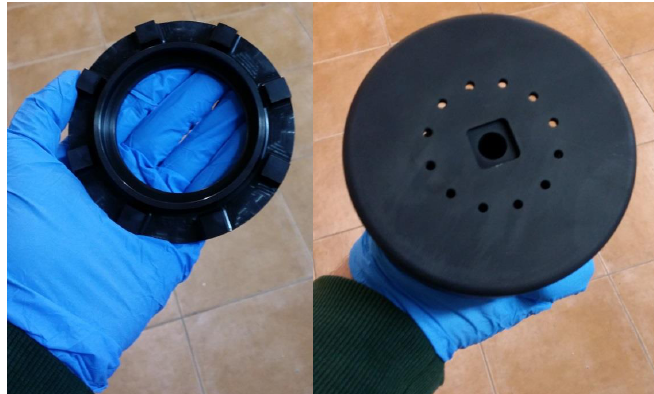
Figure 8. Antioxidation coating applied to external and internal parts.